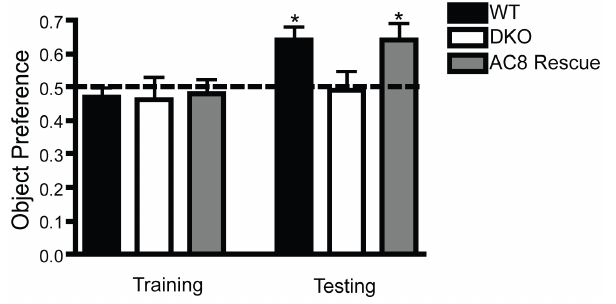
Figure 7. Ca2 + -stimulated AC activity is necessary for the acquisition of novel object recognition. The hash mark labels the 50% mark, which represents no preference for an object (object preference = novel object interaction/total object interaction). DKO mice show no preference for the novel object when tested 90 min after training (n=8, object preference is not significantly different than 50%, p . 0.05); however, replacing AC8 in the forebrain of DKO mice is sufficient to maintain memory (n=10/genotype, *1-sample t-test object preference is greater than 50%, p # 0.05).